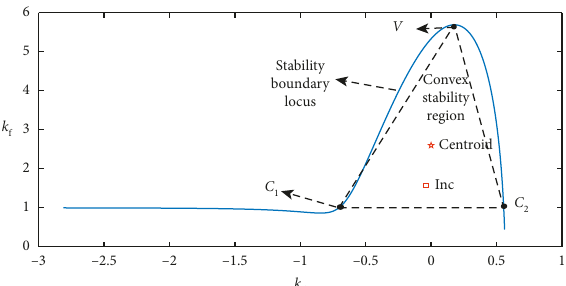
Figure 14: New corner point of inner-loop PD controller in ex- ample D.